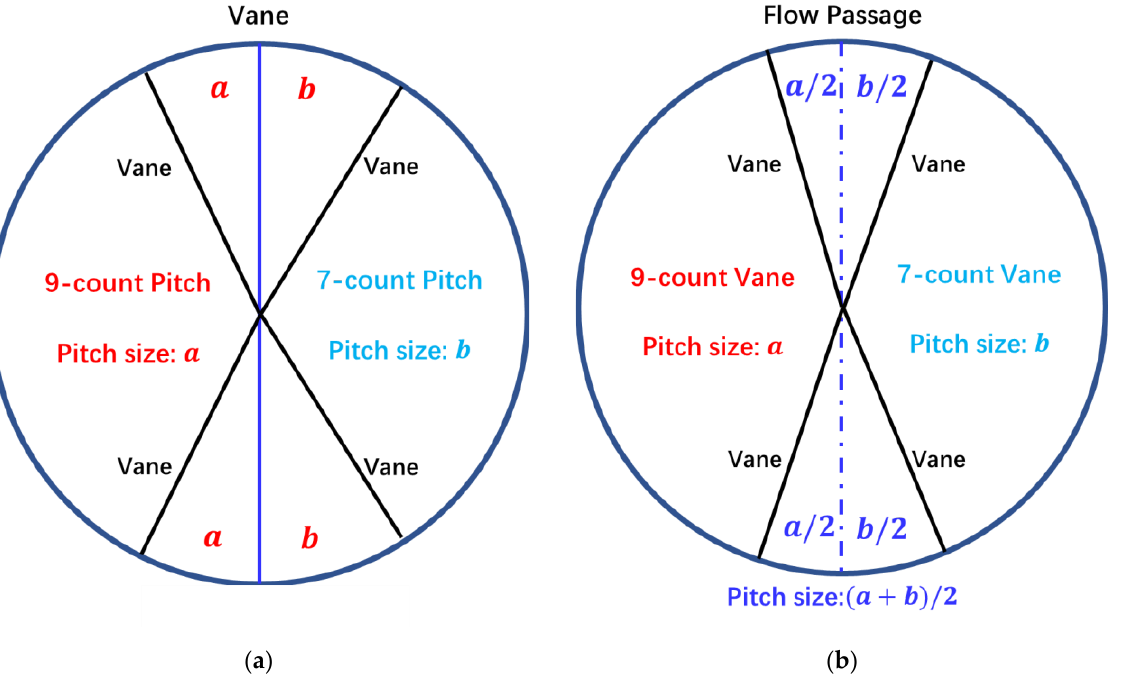
Figure 5. Schematic of different asymmetric configurations with segmentation method based on ( a ) Pitch count; ( b ) Vane count.